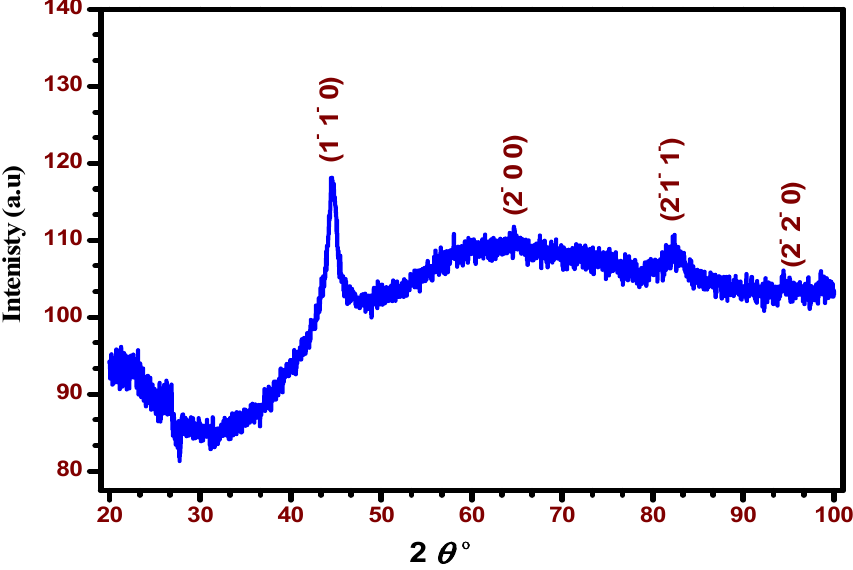
Figure 3. XRD pattern of ZVI nanoparticles synthesized at optimum conditions.